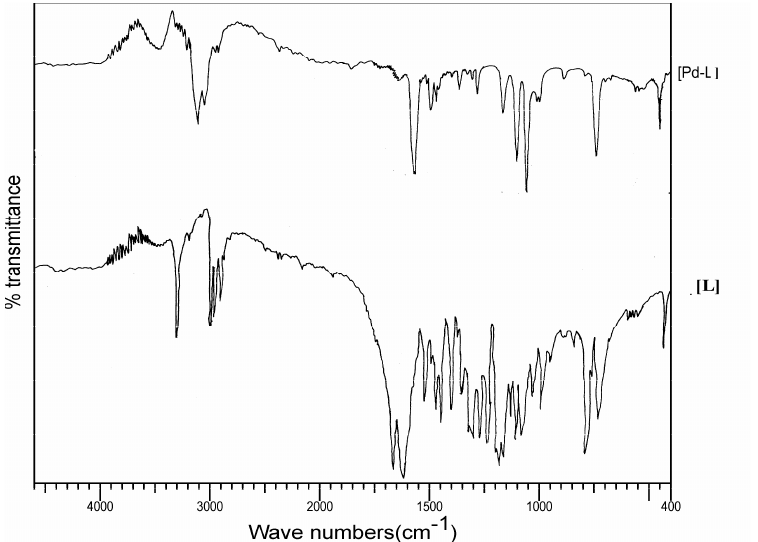
Figure 1. IR spectra of macrocyclic ligand and its complex [Pd-L]